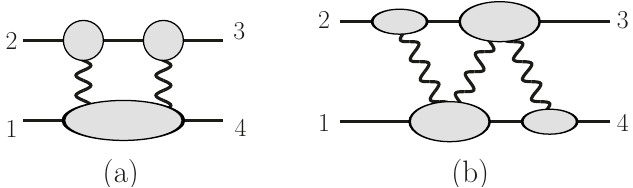
Figure 5 . Some generalized unitarity cuts for extracting the conservative two-body potential at (a) 2PM order and (b) at 3PM order. The blobs represent tree amplitudes and exposed lines are all on shell. Straight lines represent massive scalars and the wiggly lines are either gluons or gravitons, depending on whether we are considering a gauge theory or a gravity